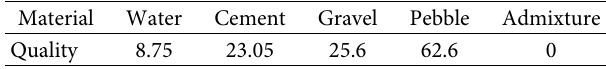
Table 1: C30 concrete mix ratio (kg).